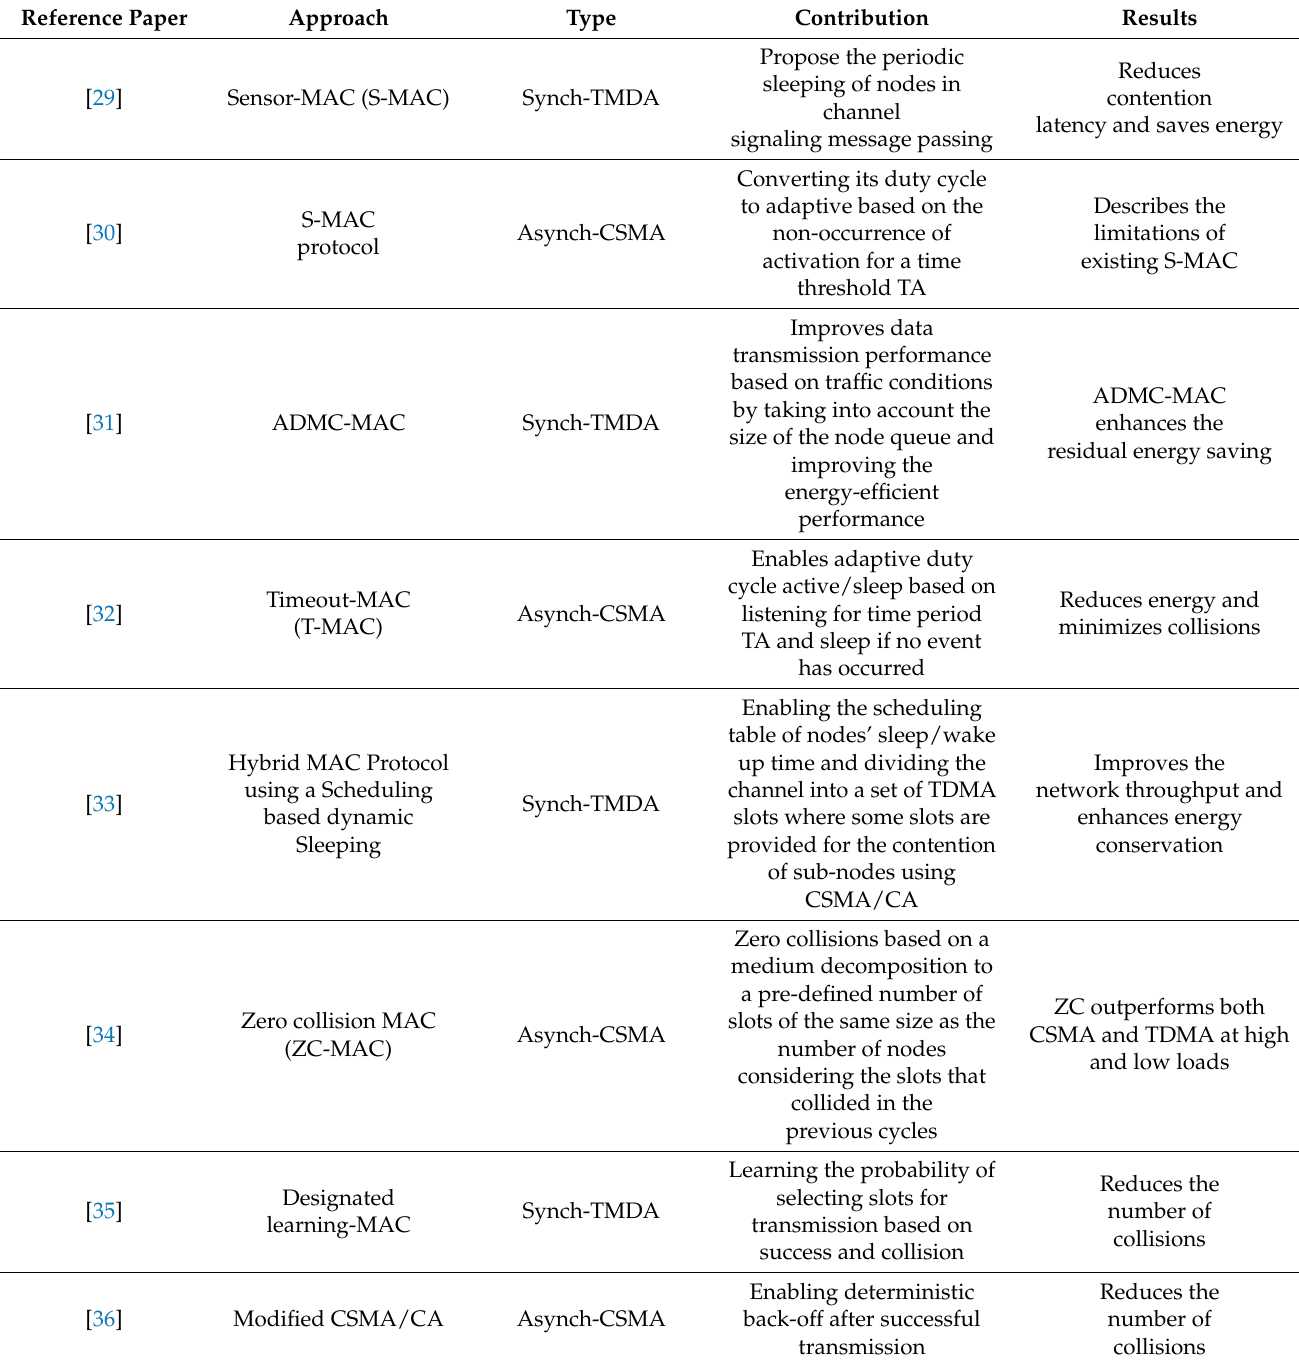
Table 1. General approaches for the MAC